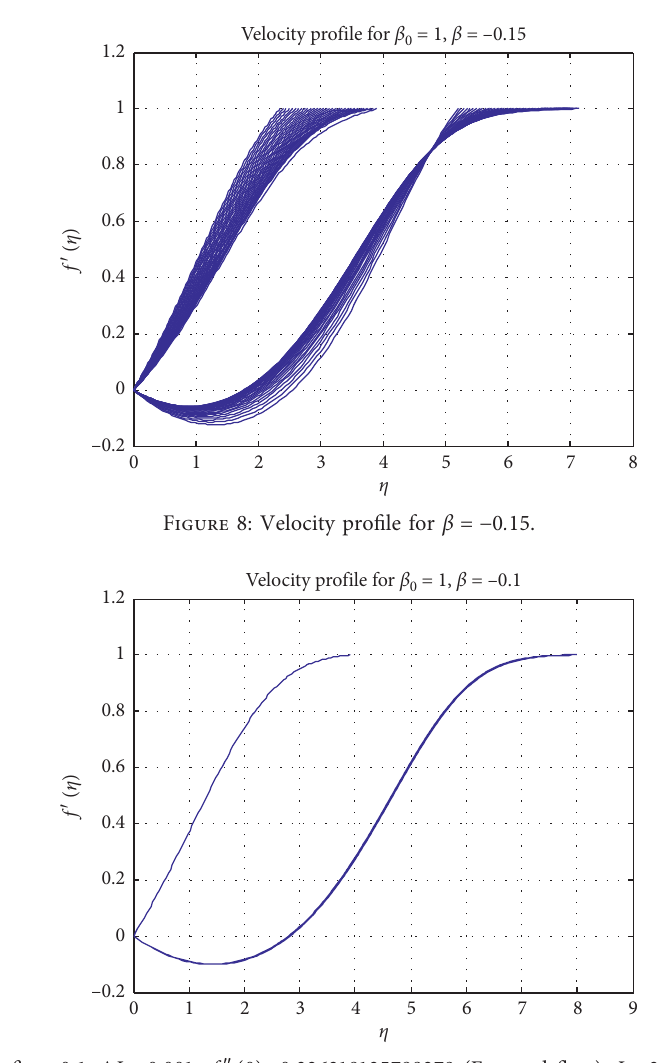
Figure 9: Velocity profile for β � − 0 . 1, Δ L � 0.001; f ″ ( 0 ) � 0.326218125788279 (Forward flow), L � 3.913; f ″ ( 0 ) �− 0.140741363248159 (reverse flow), L � 8.